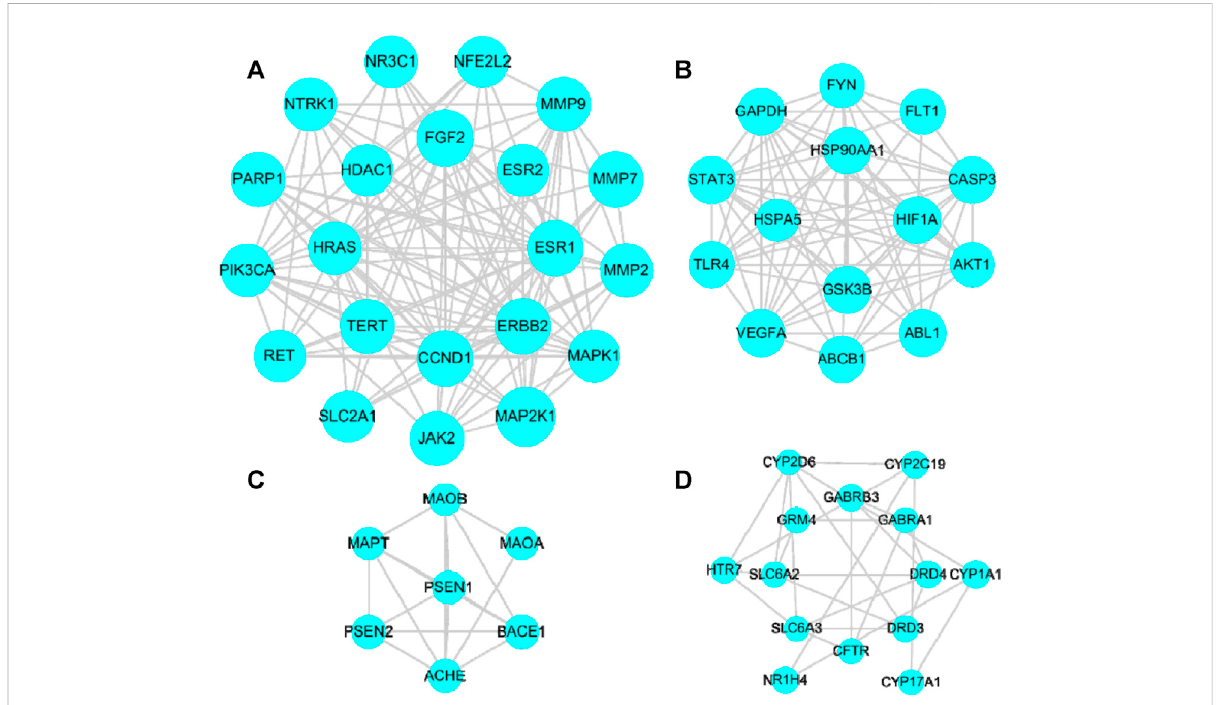
FIGURE 6 Signi fi cantclustersanalysis. (A) :Clustermodule(score=12.30),including21nodesand123edges; (B) :Clustermodule(score=11.38),including 14 nodes and 74 edges; (C) : Cluster module (score = 5.33), including 7 nodes and 16 edges; (D) : Cluster module (score = 4.00), including 14 nodes and 26